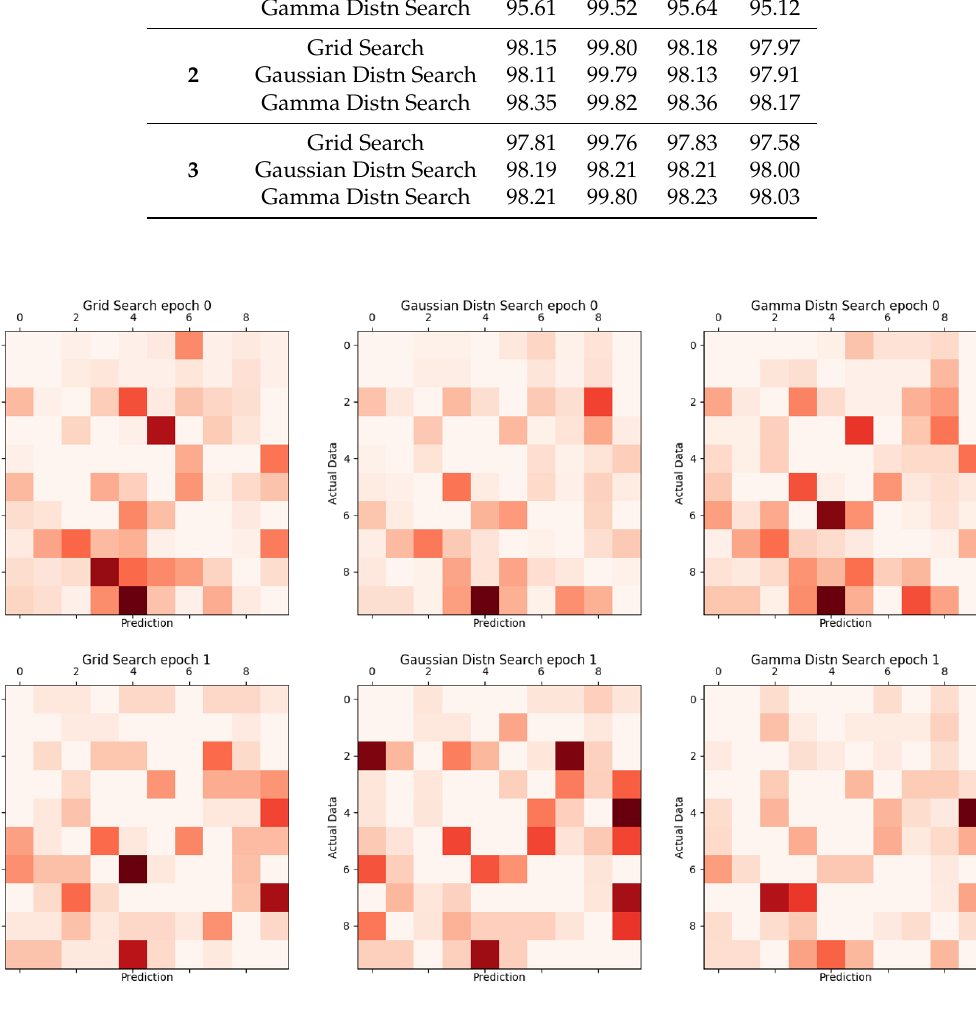
Figure 14. Proposed comparison of grid search, Gaussian distribution search, and Gamma distribution